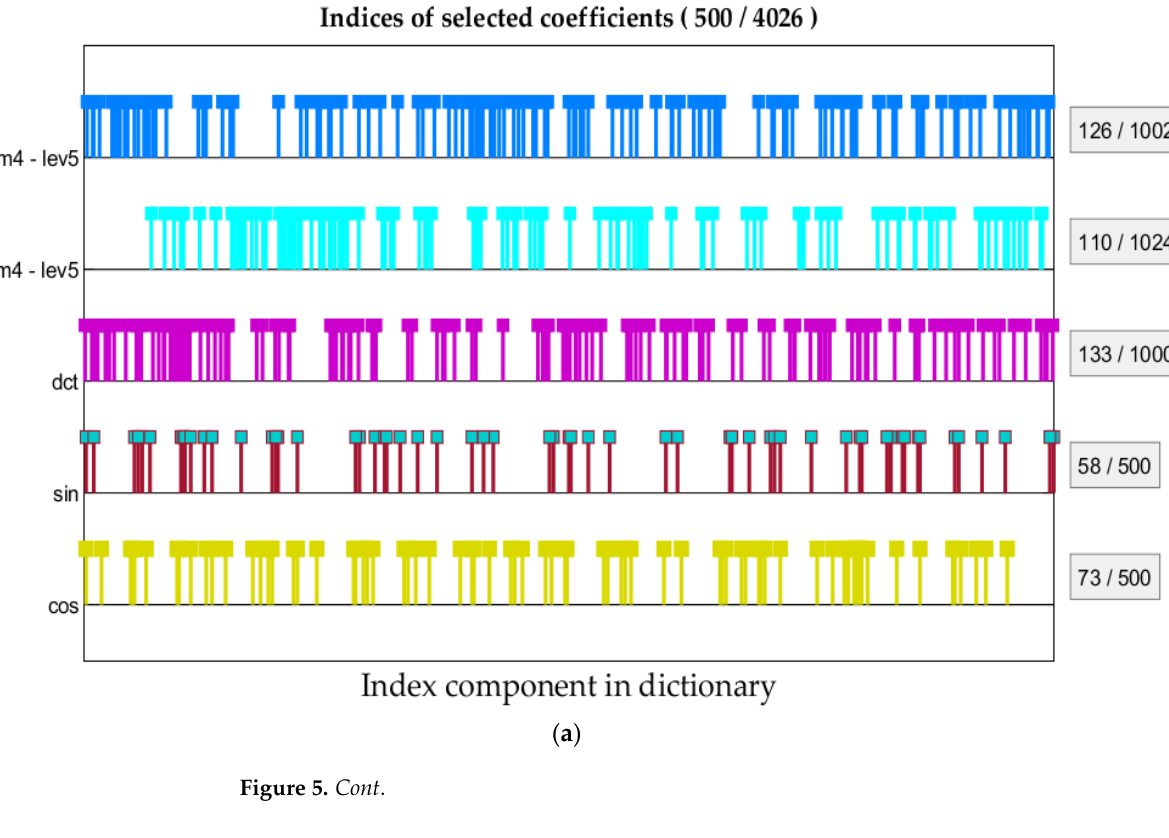
( b ) Figure 5. Stator current ( I (cid:2870) ) signal using OMP for One-Broken Rotor Bar fault, operating at 1480 rpm. ( a ) Indices of selected coefficients; ( b ) Original signal and its components. 3.1.4. Decomposition Using (DWT) Among the various types of the wavelet transform, Discrete Wavelet Transform (DWT) has proved its power to extract the initial features in many applications of